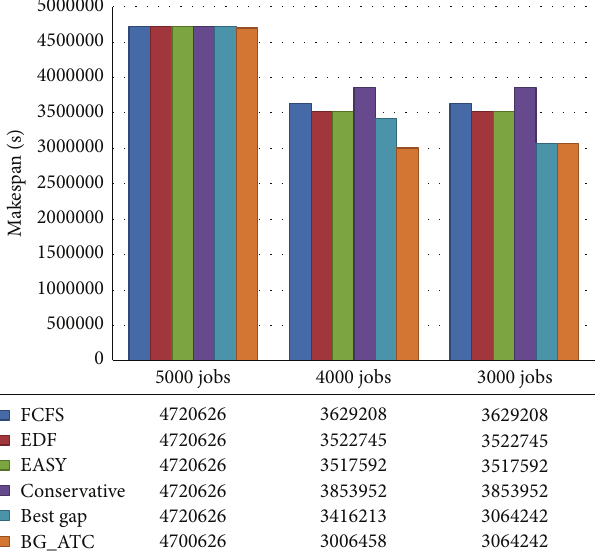
Figure 6: Makespan comparison on metacentrum workload.